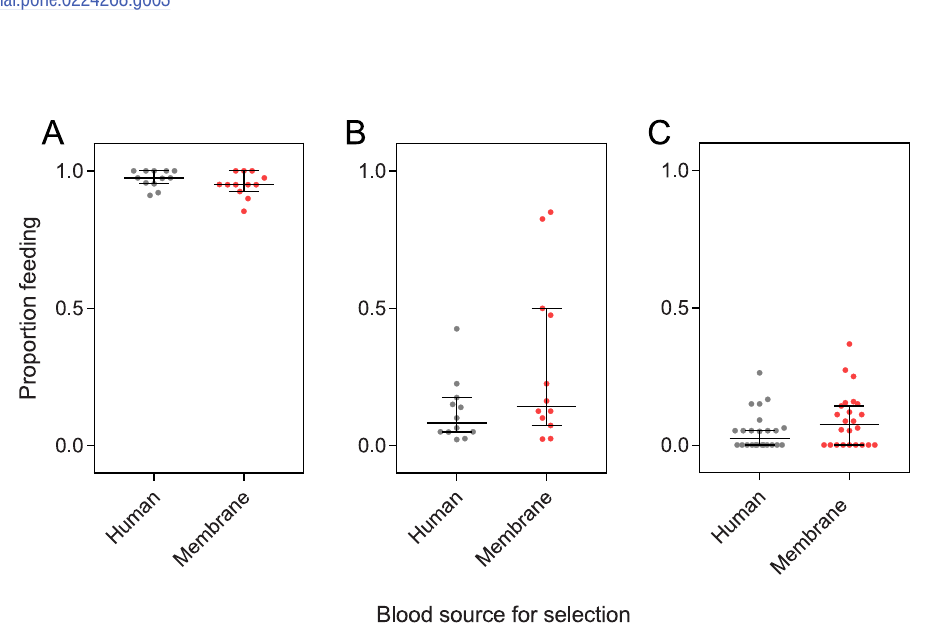
Fig 4. Proportion of Aedes aegypti females selected on human arms or membrane feeders that were visibly engorged when provided access to a human arm (A) or membrane feeder (B,C) for 10 min. For experiments with membrane feeders, human-selected and membrane-selected populations were tested in separate cages (B) or in mixed cohorts in the same cage (C) where populations were marked with different colors of fluorescent powder. Data for all four populations selected for feeding on each blood source were pooled. Bars are medians and 95% confidence intervals.